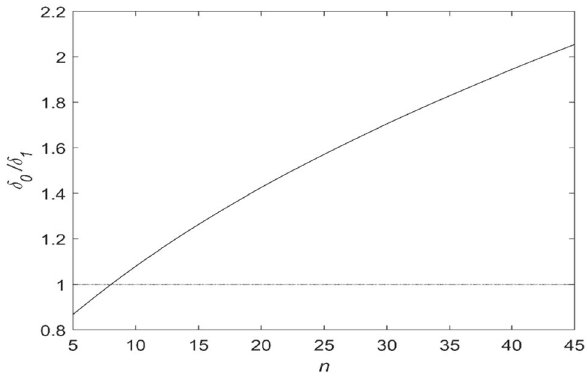
Figure 2. The ratio of relative pulse period determination errors δ 0 /δ 1 , where δ 0 and δ 1 are relative errors of the MLE and CSS methods respectively.